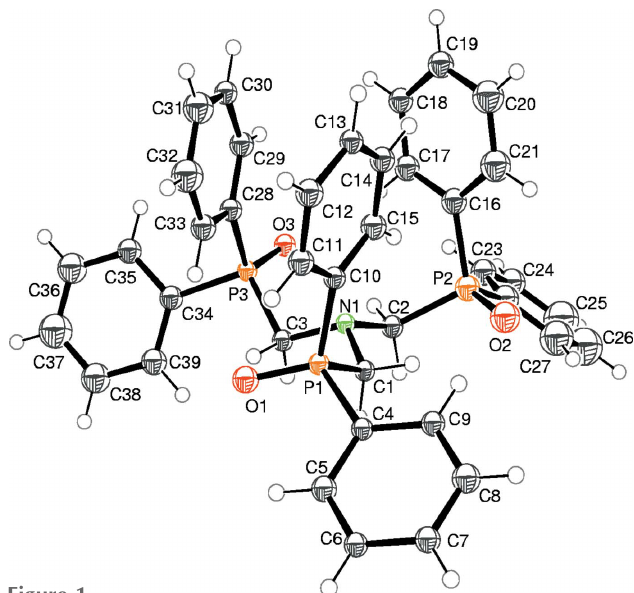
Figure 1 View of the molecular structure of one of the molecules of N , N , N - tris(diphenylphosphorylmethyl)amine in the asymmetric unit, showing the atom-labelling scheme. Displacement ellipsoids are drawn at the 50% probability level.